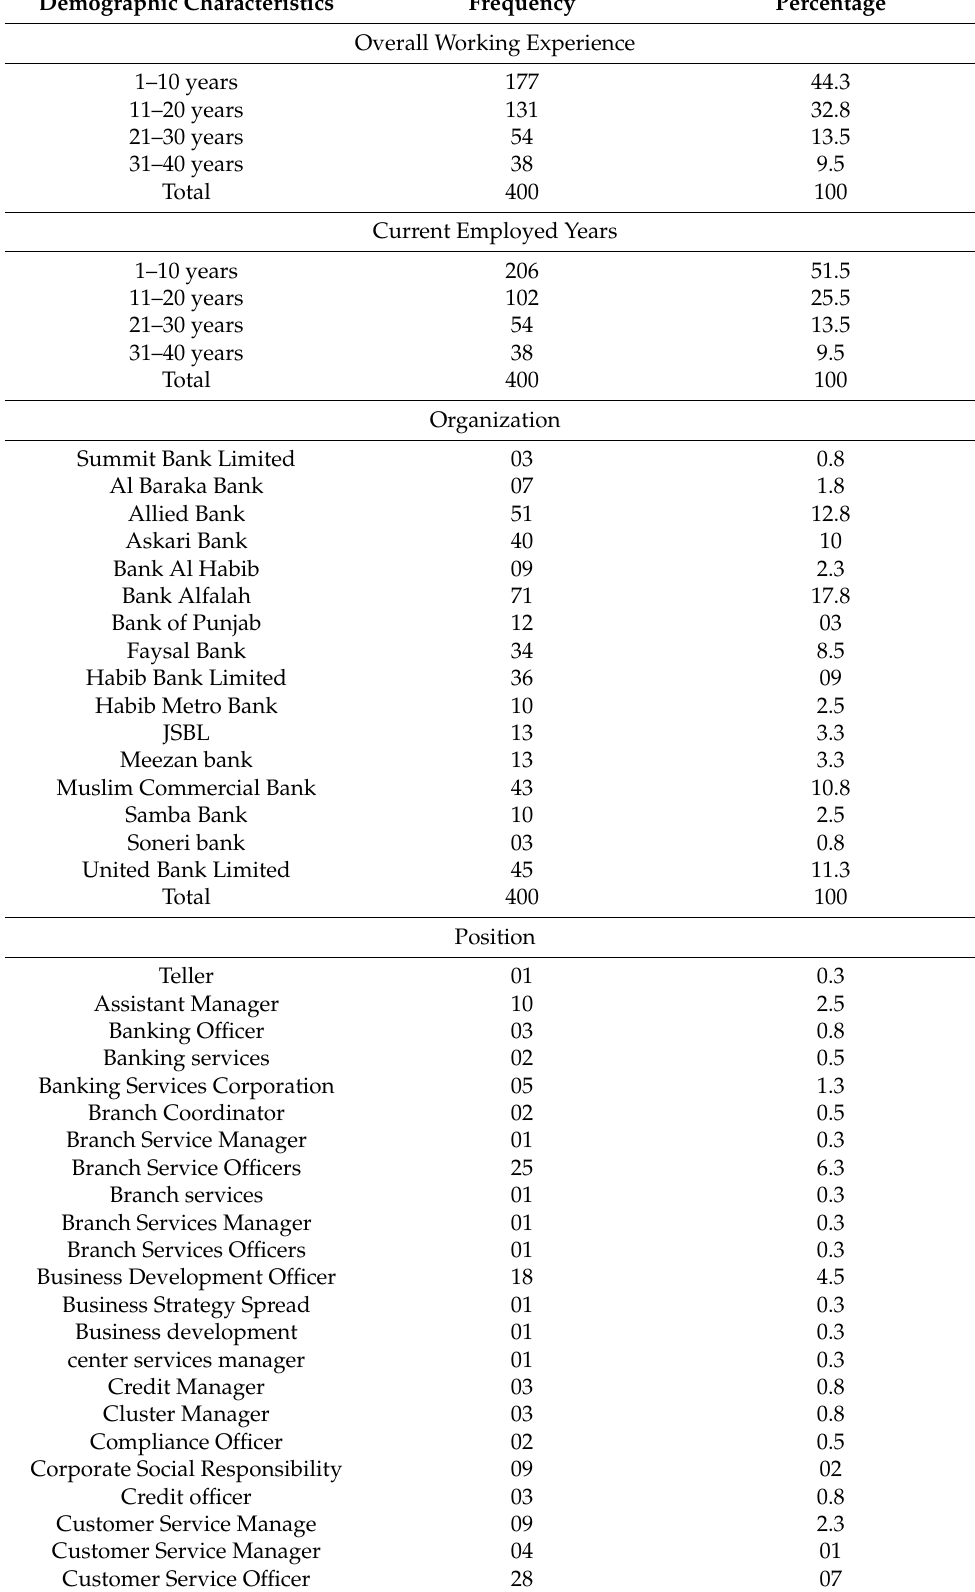
Table A1. Cont . Demographic